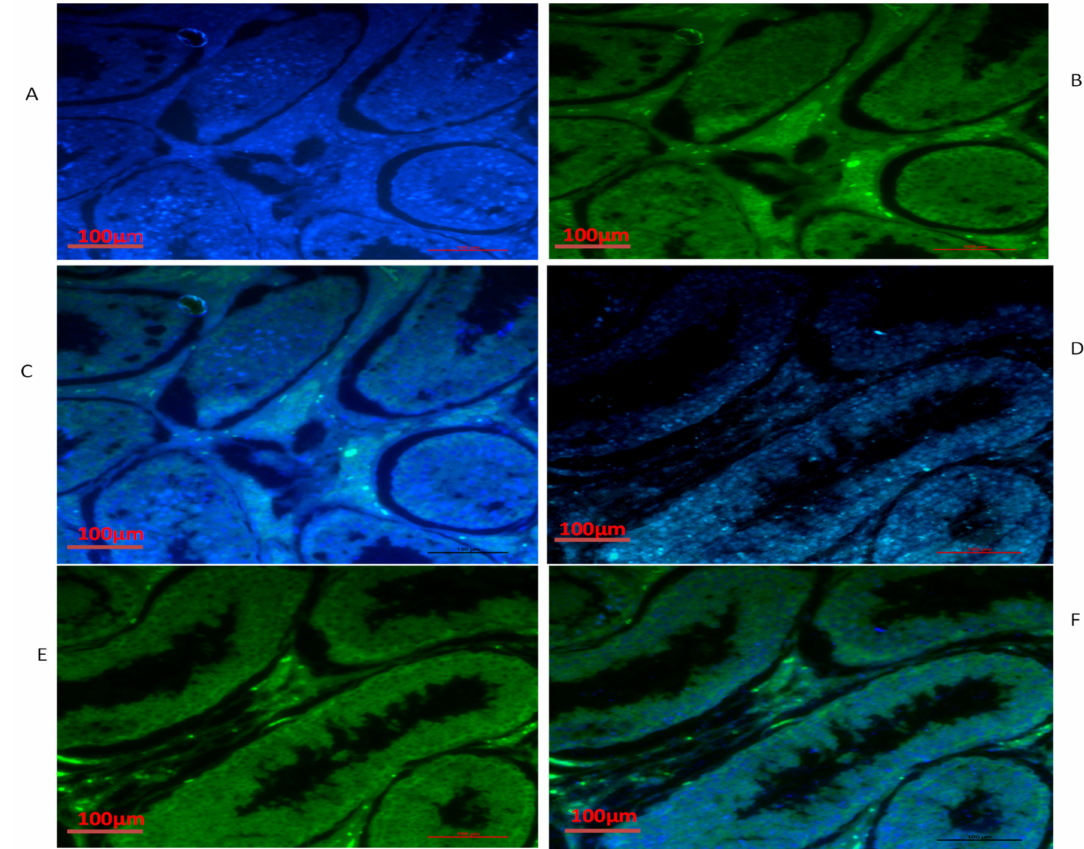
Figure 6. Immunofluorescence localization of TEX11 under various feeding conditions in yak testes: ( A – C ) natural grazing without concentrate supplementation; ( D – F ) natural grazing plus concentrate supplementation. Scale bar = 100 µ m ( A – F